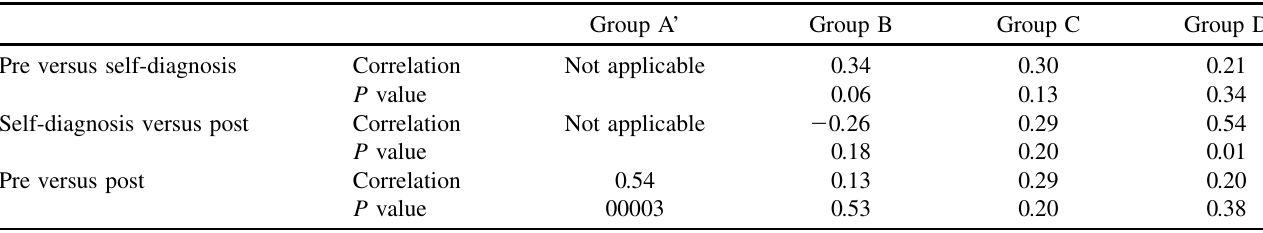
TABLE IX. Correlations between pre and self-diagnosis scores, between self-diagnosis and post scores, and between pre and post